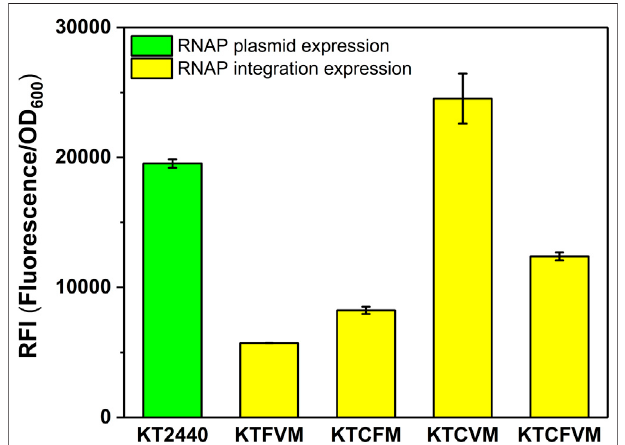
FIGURE 3 | The effect of different copy numbers of Mmp1 RNAP on expression. KT2440: KT2440 harboring the plasmid containing the MmP1 RNAP module and sfGFP with MmP1 promoter; KTFVM: KTFVM with insertion sites of phaF and vdh harboring the plasmid containing sfGFP withMmP1promoter;KTCFM:KTCFMwithinsertionsitesof phaC1 and phaF harboring the plasmid containing sfGFP with MmP1 promoter; KTCVM: KTCVM with insertion sites of phaC1 and vdh harboring the plasmid containing sfGFP with MmP1 promoter; KTCFVM: KTCFVM with insertion sites of phaC1 , phaF and vdh harboring the plasmid containing sfGFP with MmP1 promoter.